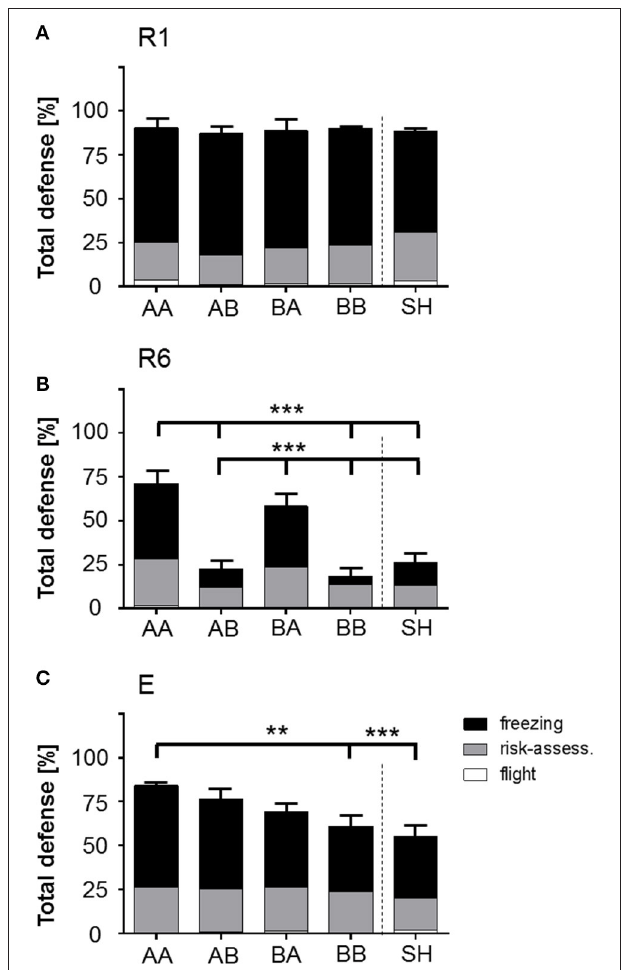
FIGURE 5 | Stacked bar graphs illustrate the expression of total defensive behaviors in response to CS + presentation during fear retrieval (R1), extinction (R6), and extinction recall (E). Total defense (TD; freezing, risk-assessment, flight; % of time) scored for mean of all four CS + presentations during R1, R6, and E showed that (A) during R1, all groups similarly expressed defensive behaviors upon stimulus presentation. (B) R6: At the end of extinction training, AA and BA animals showed significantly elevated levels of TD in comparison to other life histories, which were mainly a result of significantly prolonged freezing periods upon stimulus presentation. (C) E: AA animals showed significantly increased TD in comparison to BB and SH animals due to elevated freezing. Life histories: AA, early and late adversity; AB, early adversity and late benefit; BA, early benefit and late adversity;